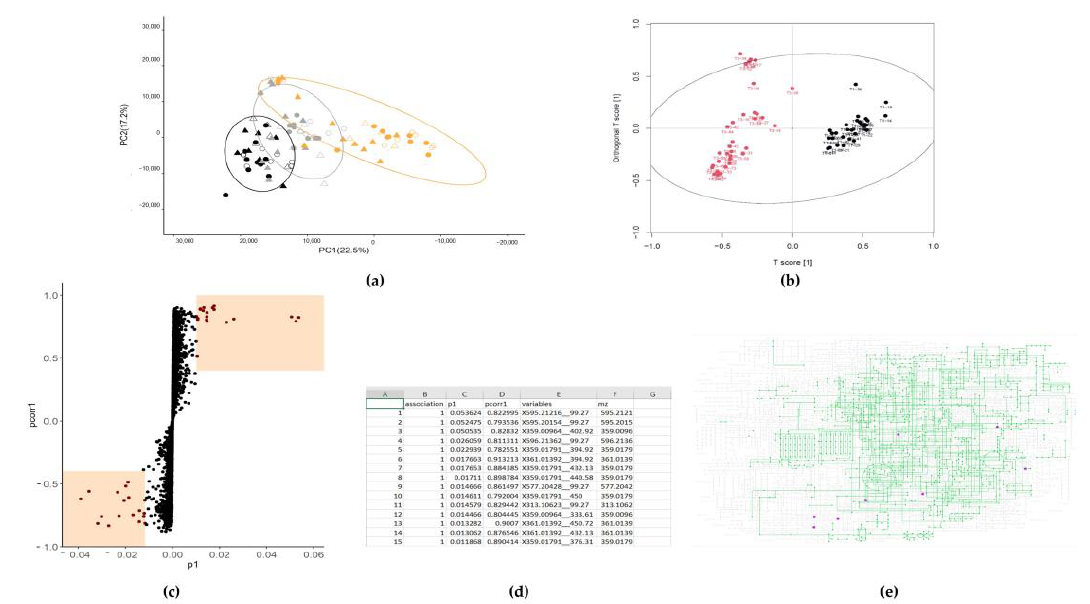
Figure 3. Conceptual diagram of examples of multivariate analysis outputs of untargeted metabolomics analysis, all produced using open-source or freely available software. ( a ) Principal component analysis (PCA) 2-D scores plot produced with pcaMethods and ggplot2 packages in R; ( b ) OPLS-DA scores plot produced using the muma package in R; ( c ) scores plot created using ggplot2 package and data produced by the muma package in R; ( d ) example list of features of interest highlighted by an OPLS-DA using muma in R; ( e ) example of metabolites highlighted within a KEGG pathways global Esterichia coli metabolism map.